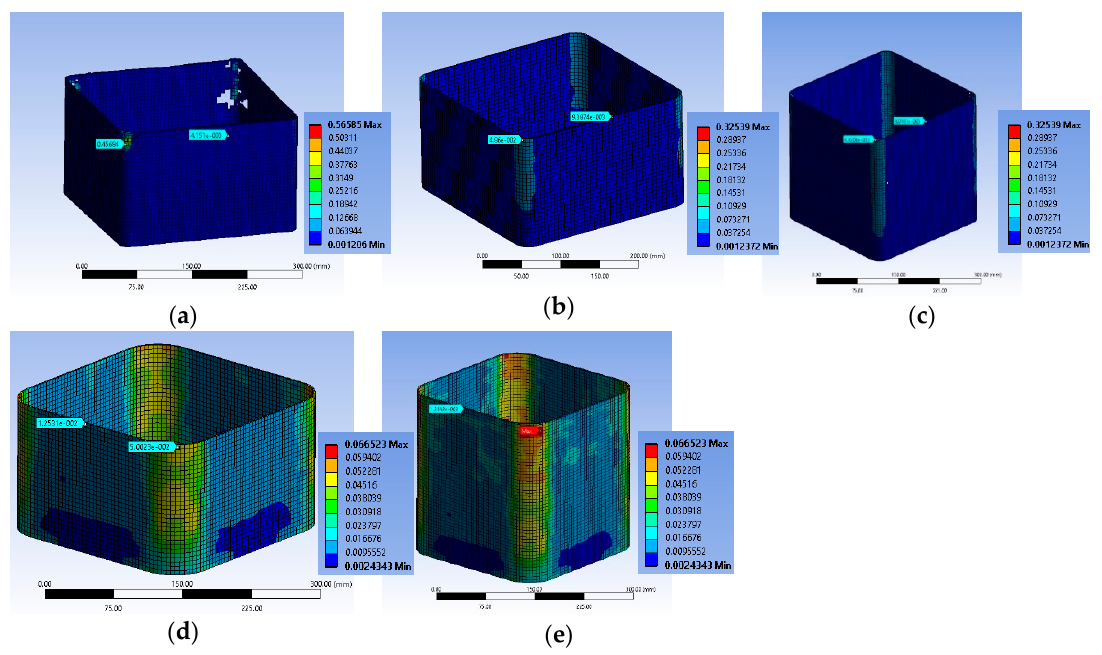
Figure 12. Variation of the CFRP strain and characteristic values of specimen LSR-R-1-3-10b ( a ) at the ultimate condition at the level of the stirrup; LSR-R-1-3-20b at the ultimate condition ( b ) at the level of the stirrup and ( c ) at the mid height of the specimen and LSR-R-1-3-40b at the ultimate condition ( d ) at the level of the stirrup and ( e ) at the mid height of the specimen.